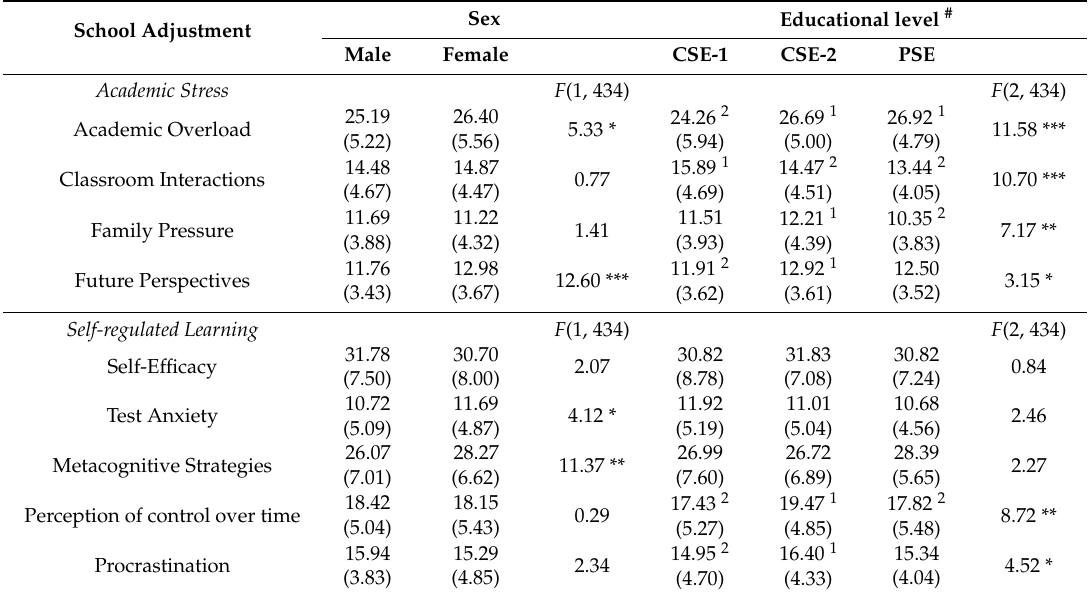
Table 3. Means, standard deviations (in parentheses), and F value between sex and educational level and the stress and self-regulated learning